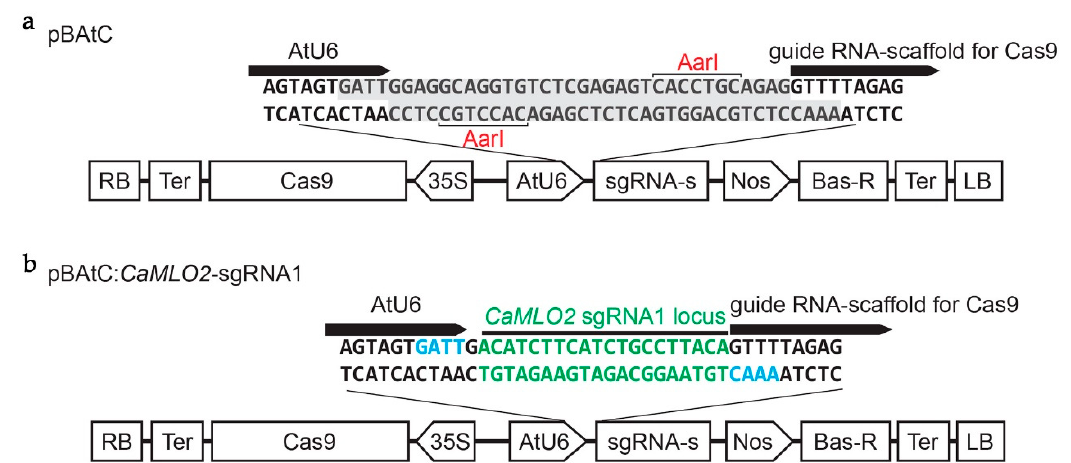
Figure 1. CaMLO2 sgRNA1 cloned pBAtC binary vector. ( a ) Description of a pBAtC binary vector. RB, right border; Ter, tetracycline; CAS9hc:NLS: HA, human-codon-optimized Cas9 with the nuclear localization signal and an HA epitope; 35S, cauliflower mosaic virus (CaMV) 35S promoter; AtU6, Arabidopsis thaliana U6 promoter; Aar1, sgRNA cloning sites with two Aar1; sgRNA-s, the guide RNA-scaffold for Cas9; Nos, nos promoter; Bas-R, BASTA resistance gene; LB, left border; ( b ) Description of a pBAtC: CaMLO2 –sgRNA1 binary vector. Green, the sgRNA1 sequence of CaMLO2 target locus; Blue, overhangs digested by Aar1 sites.